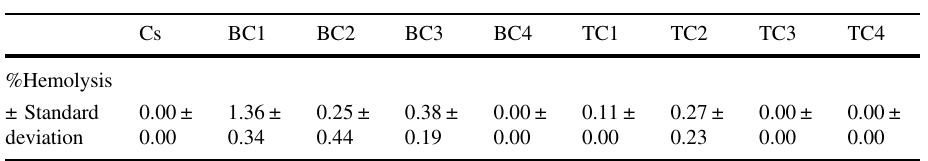
Table 3 Hemolysis test results